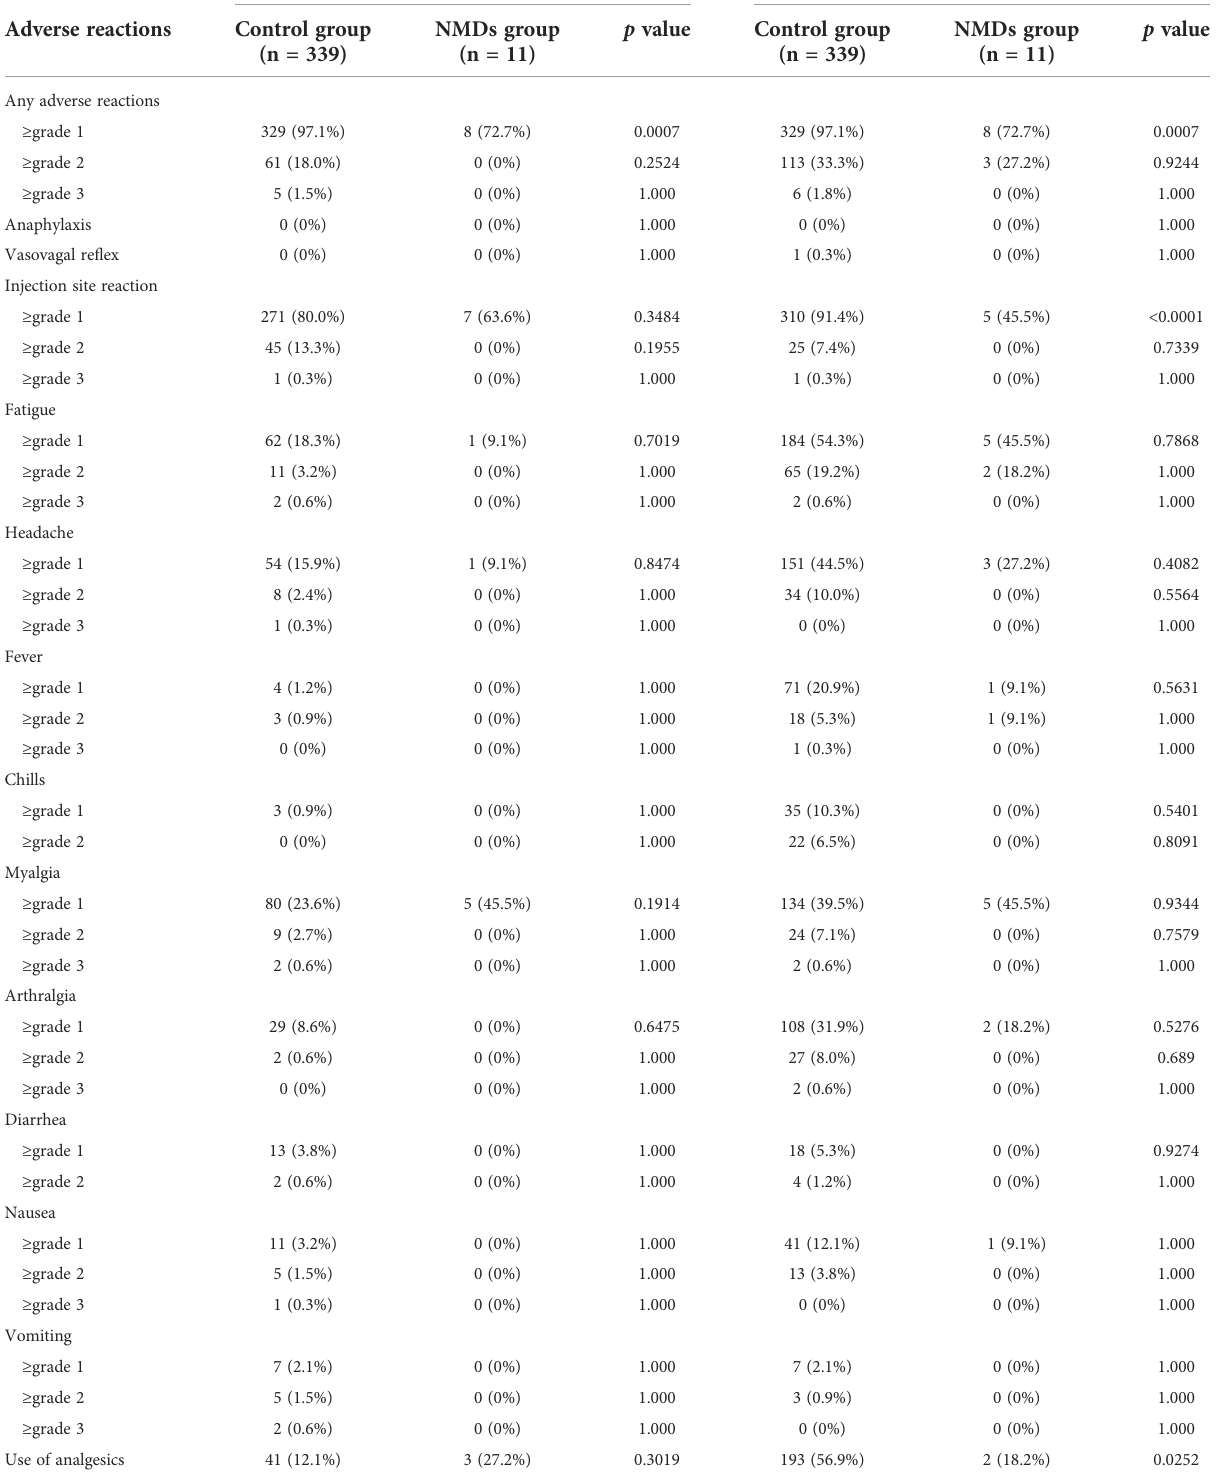
TABLE 3 Adverse reactions observed in the control and NMD groups. After the fi rst vaccination After the second